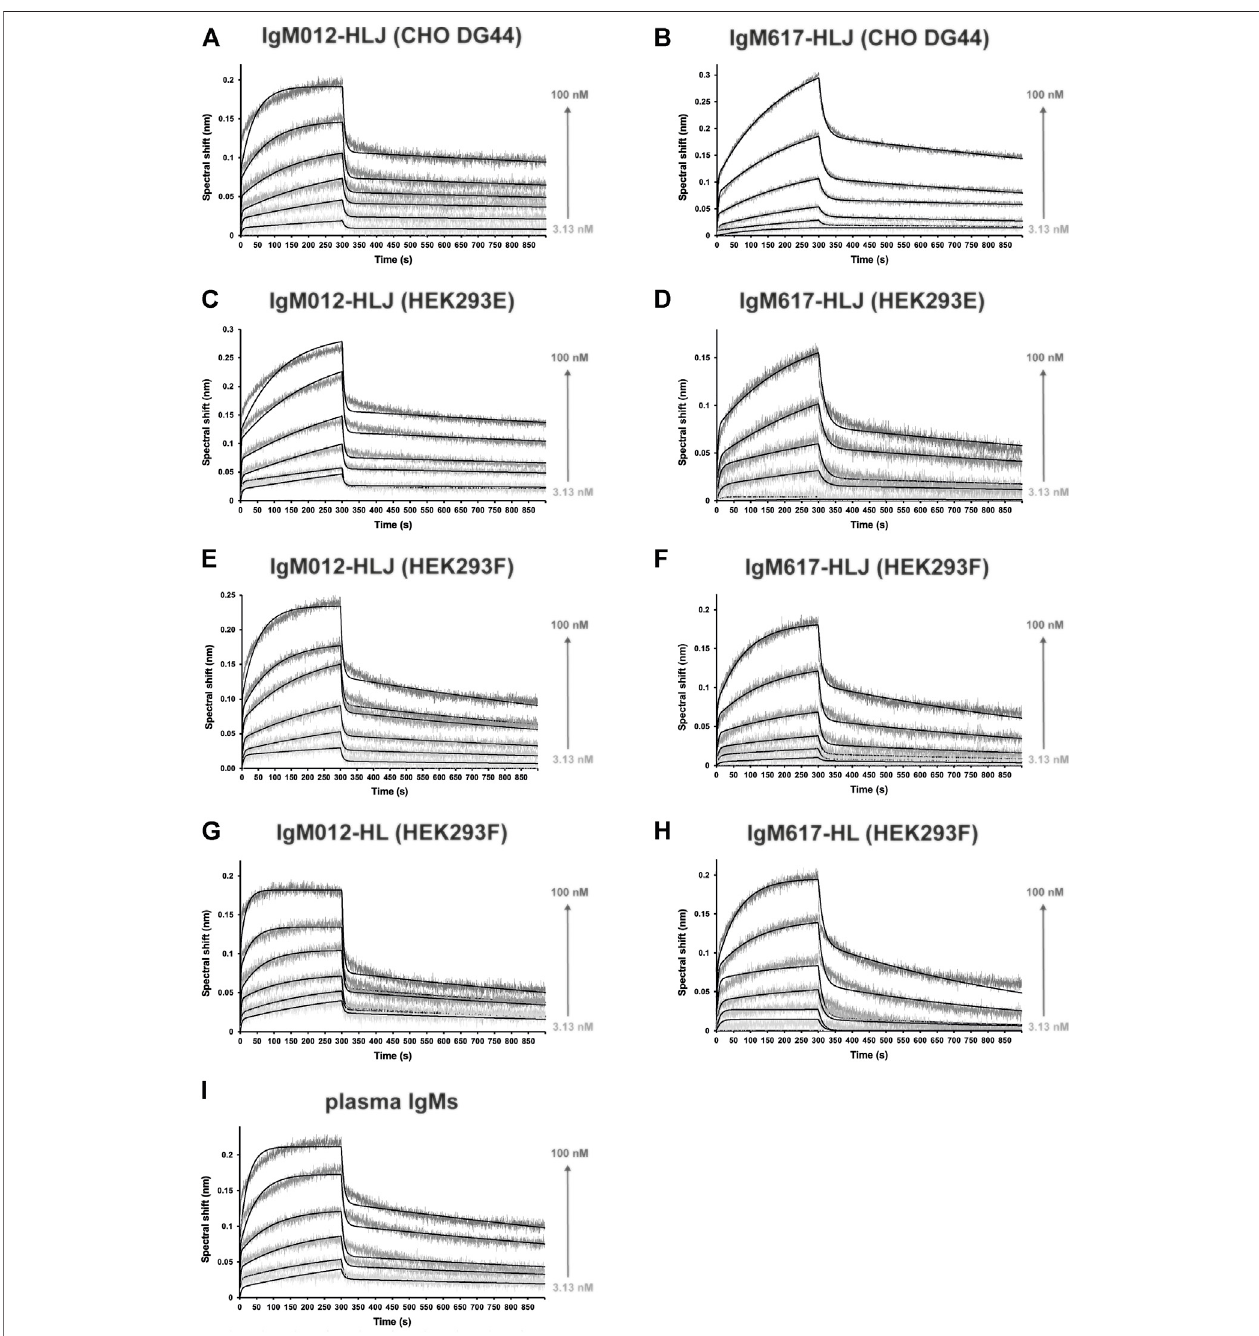
FIGURE 6 | Kinetics analysis of the interaction between C1q from plasma and the different puri fi ed and immobilized IgMs expressed in mammalian expression hosts. IgMs were captured on Protein L, and functionalized biosensors were dipped in wells containing C1q at different concentrations (3.13, 6.25, 12.5, 25, 50, and 100 nM).Thebindingsignals(gray-scaledsensorgrams)wereobtainedbysubtractingthesignalsfromemptyproteinLbiosensorandfromzero-concentrationsamples. Fittedcurvesaredepictedasblacklinesandwereobtainedbyglobal fi ttingusinga2:1heterogeneousligandmodel.Shownkineticsanalysesarerepresentativeof eachbindingexperiment: (A) IgM012-HLJexpressedbyCHODG44, (B) IgM617-HLJbyCHODG44, (C) IgM012-HLJbyHEK293E, (D) IgM617-HLJbyHEK293E, (E) IgM012-HLJ by HEK293F, (F) IgM617-HLJ by HEK293F, (G) IgM012-HL by HEK293F, (H) IgM617-HL by HEK293F, and (I) IgMs puri fi ed from plasma.